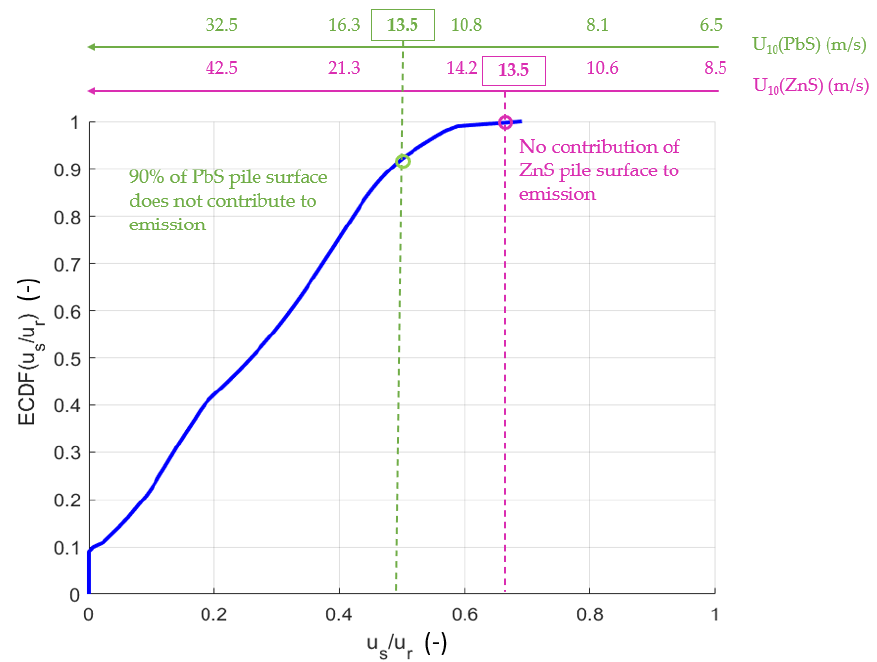
Figure 9. Empirical cumulative distribution function of u s /u r ratio for a low rectangular heap (LR) and wind from North. Lead Glance (green, PbS); and Zinc Blende (magenta, ZnS).